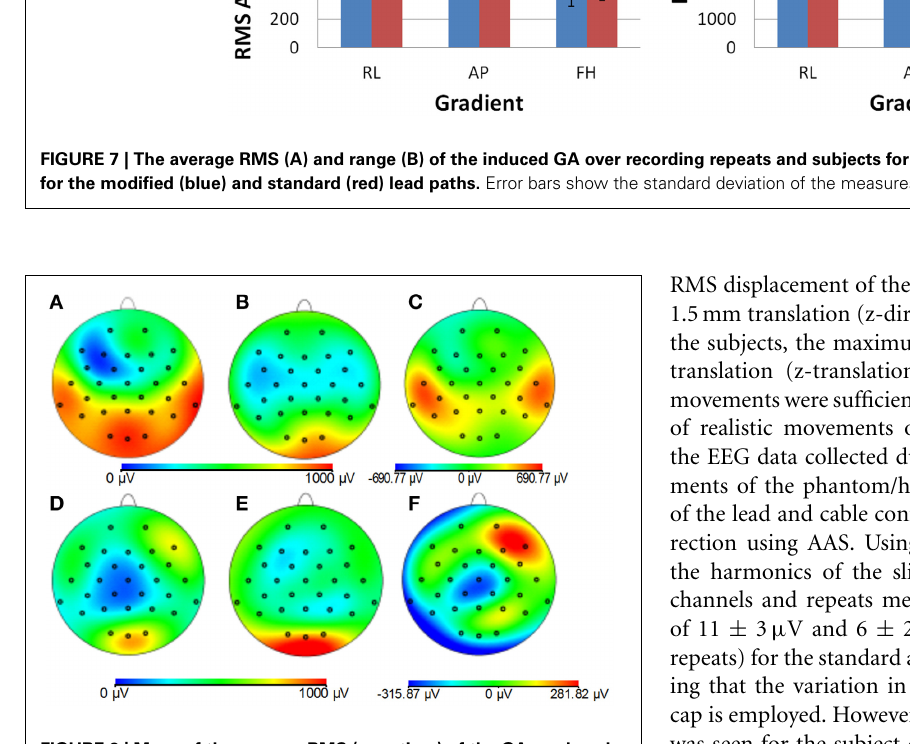
FIGURE 8 | Maps of the average RMS (over time) of the GA produced by a multi-slice EPI acquisition with the standard cap (A,D); modified cap (B,E) on the phantom (A–C) and the subjects (D–F). (C,F) Show the difference in the induced GA between caps ( A,B,D,E ,